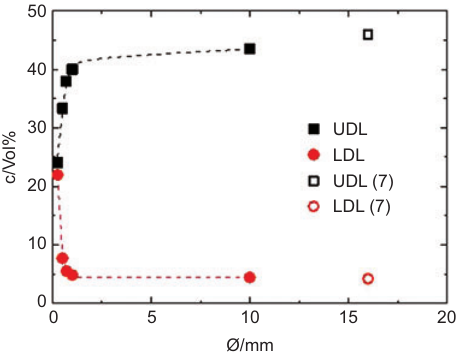
(B) Quenching of a C